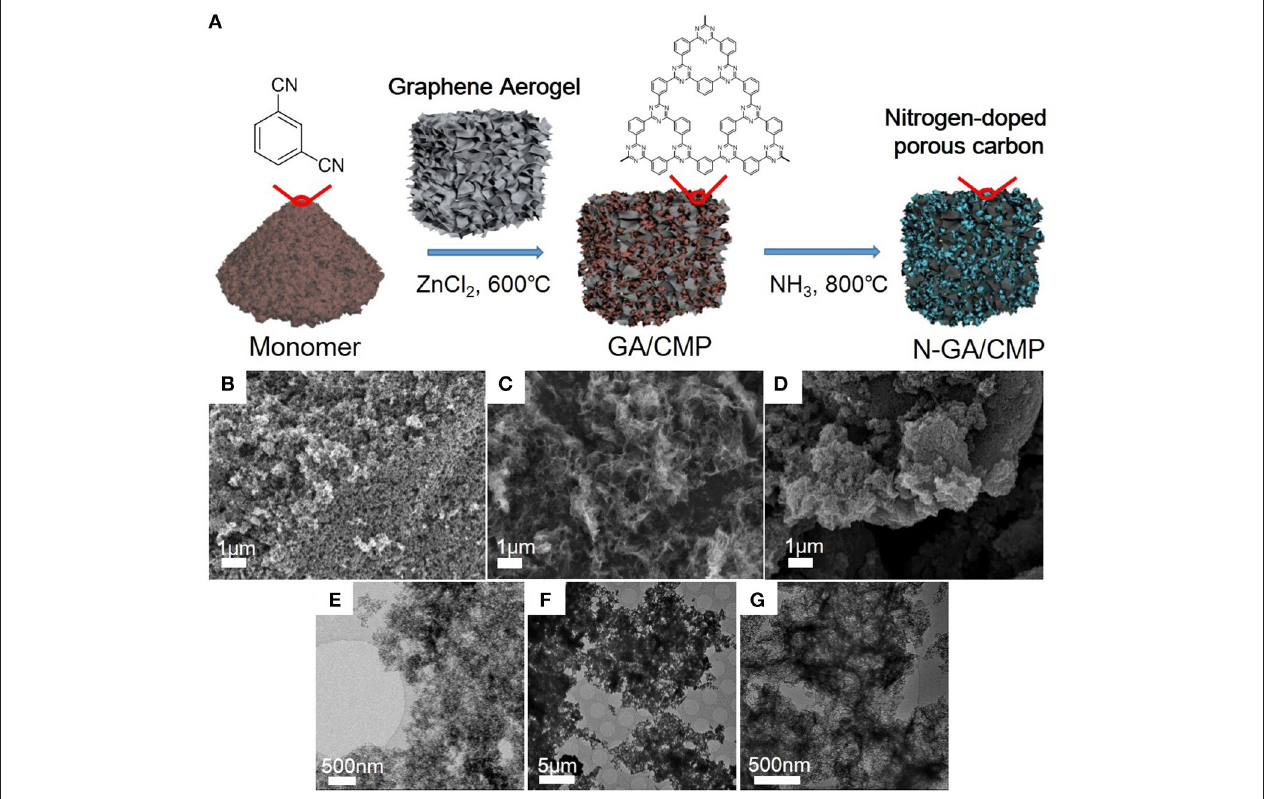
FIGURE 1 | (A) Illustration of synthesis of N-GA/CMPs. (B–G) FESEM and TEM images of the CMPs (B,E) , GA (C,F), and N-GA/CMPs (D,G) , respectively.